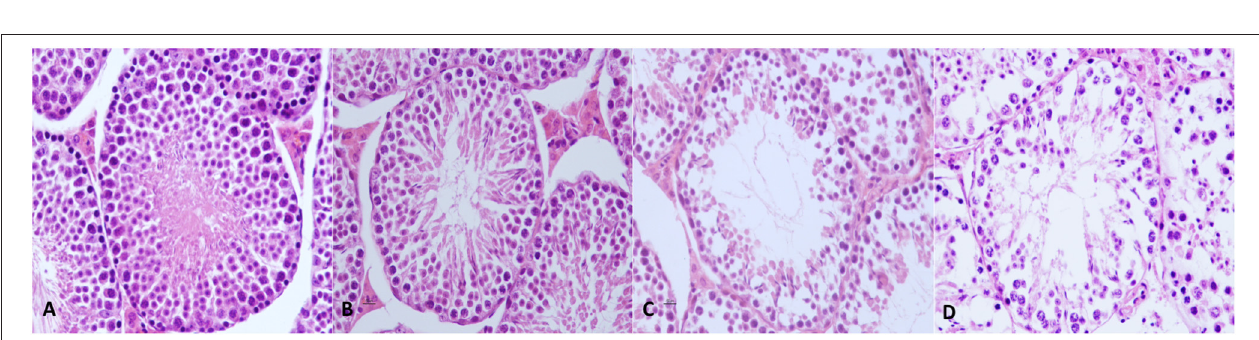
FIGURE 2 | Percentage of vascularization from color Doppler images. Boxplot showing the distribution of post-treatment PV (%) stratified by experimental groups. Boxes represent the 25th to 75th percentile, the line represents the median and the whisker represents the min and max aside outliers that are reported outside the whiskers.